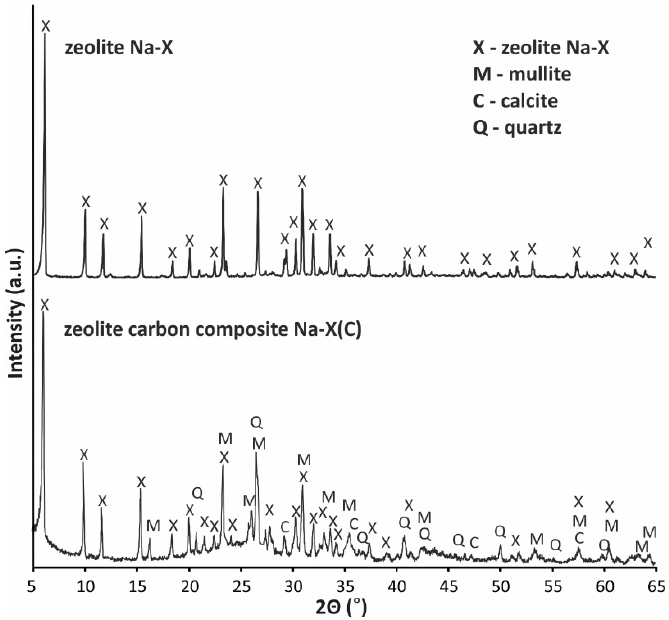
Figure 4. Phase analysis of zeolite–carbon Na-X(C) composite and Na-X zeolite.